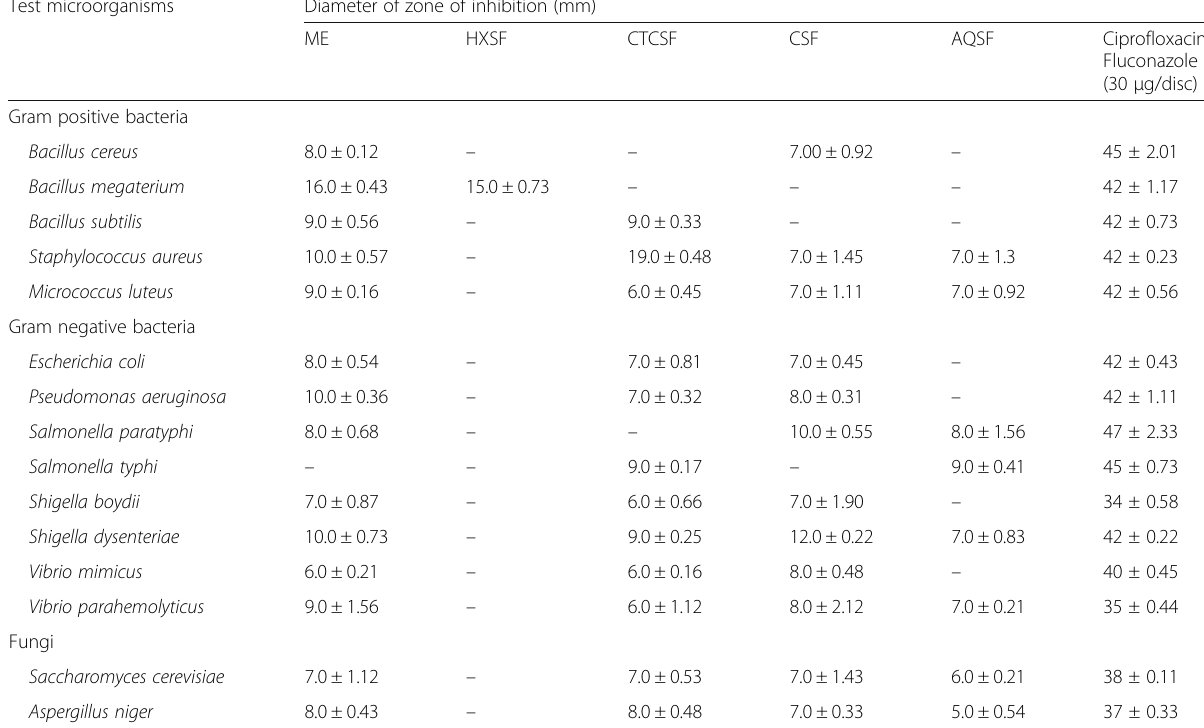
Table 3 Antimicrobial activity of test samples of L. speciosa Test